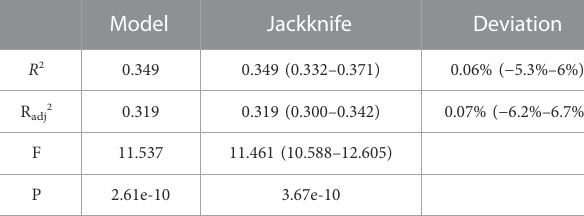
TABLE 1 Three groups of six predictors for the seasonal prediction models. Group no.